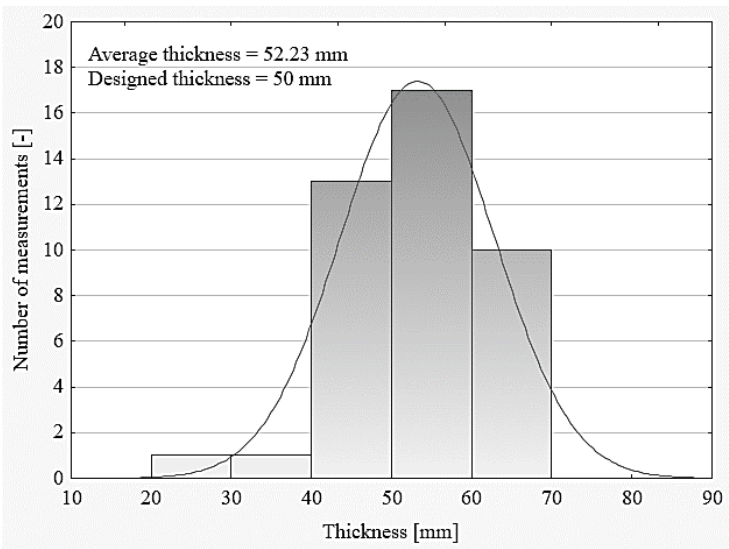
Figure 9. The thickness of the floors in comparison with the designed thickness (based on the data presented in